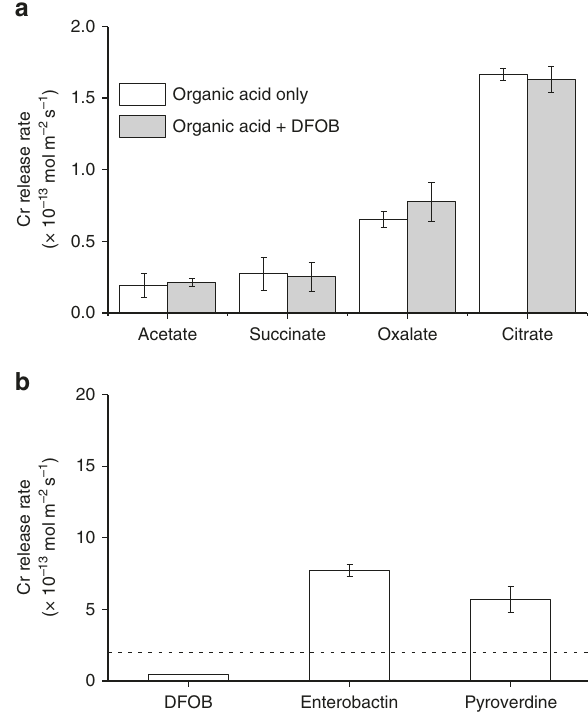
Fig. 2 Cr dissolution rate in the presence of different ligands. The initial surface area normalized release rates of Cr from Cr(OH) 3 in the presence of a organic acids with and without the siderophore, desferrioxamine B (DFOB), or b siderophores only. The dashed line in ( b ) is at the maximum y -value of ( a ). The average rates of replicates are presented with error bars re fl ecting standard deviation between replicates. Experimental